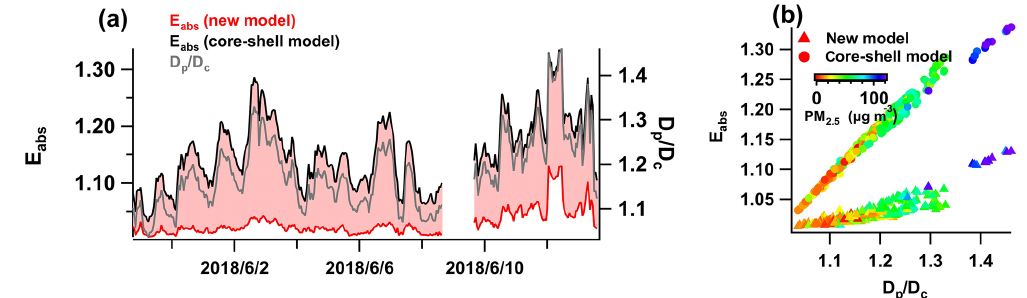
Figure 12. (a) Time series of D p /D c with D c = 180 ± 10nm and E abs at 550nm wavelength using the core–shell model and the morphology- dependent model. (b) Relationship between E abs and D p /D c . Circles denote the E abs derived from the core–shell model, and triangles denote the E abs derived from the morphology-dependent